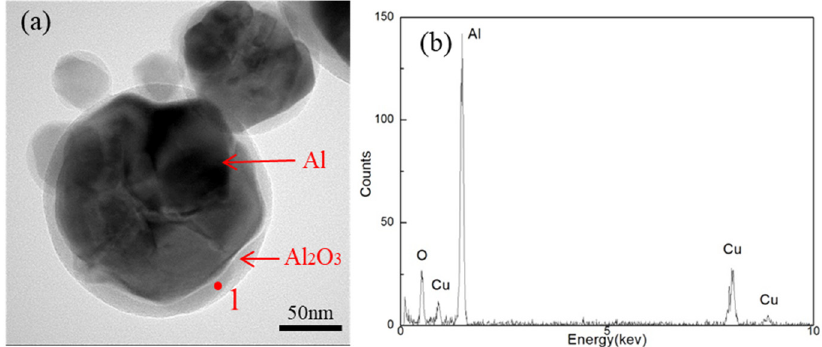
Figure 7. TEM image and EDS analysis of aluminum powder after sintering at 620 °C. ( a ): TEM image of aluminum powder, ( b ): EDS spectrum of point 1 of ( a ).